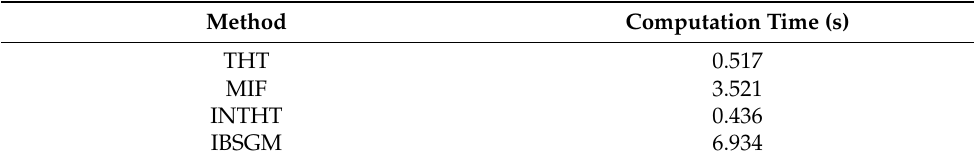
Table 4. Comparison of the computation times of different